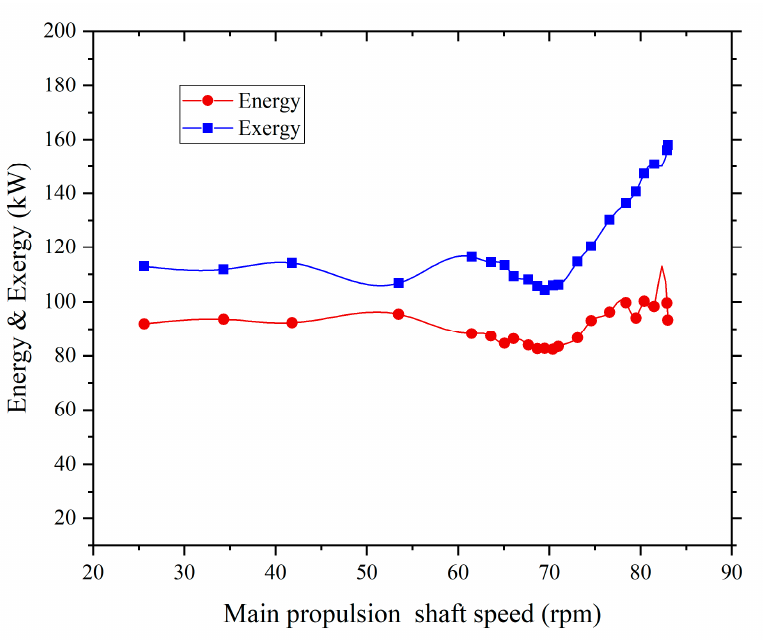
Figure 7. Energy loss and exergy destruction.